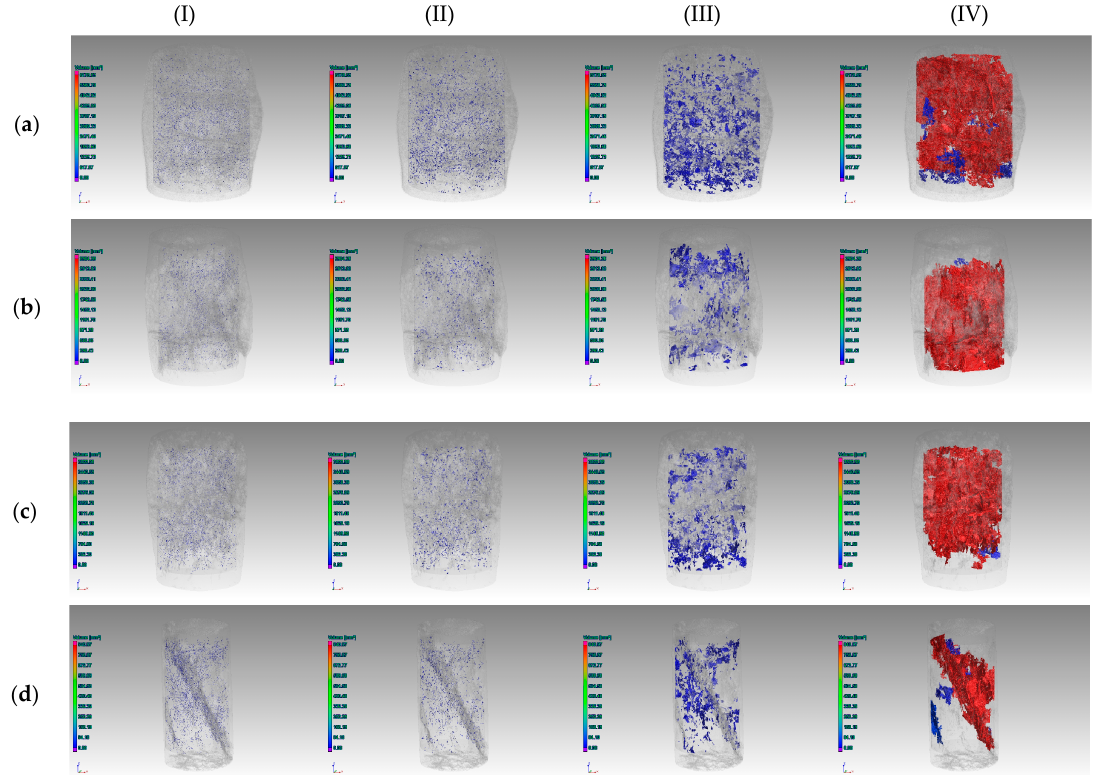
Figure 18. Crack analysis of pure salt after failure under different impurity contents. ( a ) ω = 3.00% (SR-1); ( b ) ω = 13.07% (SR-2); ( c ) ω = 39.16% (SR-3); ( d ) ω = 60.02% (SR-4).